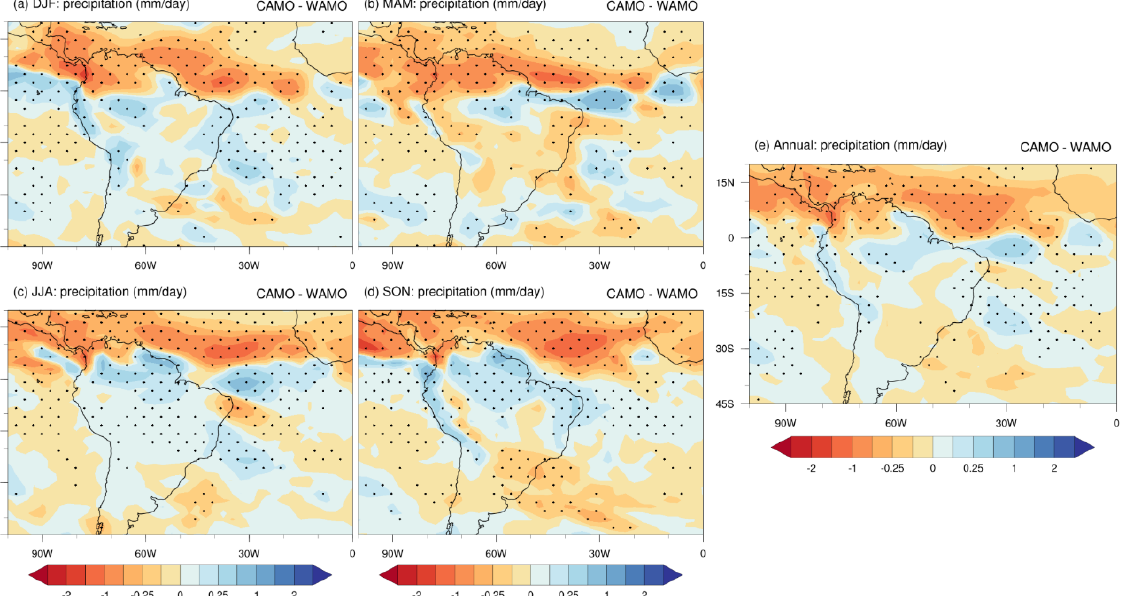
Figure 3. Streamlines and wind intensity (m/s) at 200 hPa for December – February (DJF) for the cold Atlantic Multidecadal Oscillation (CAMO) ( a ) and the warm Atlantic Multidecadal Oscillation (WAMO) ( b ) experiments, as well as for the differences between CAMO and WAMO ( c ). In ( c ), only statistically significant differences calculated using Student’s t test with a confidence level of 95% are shown.